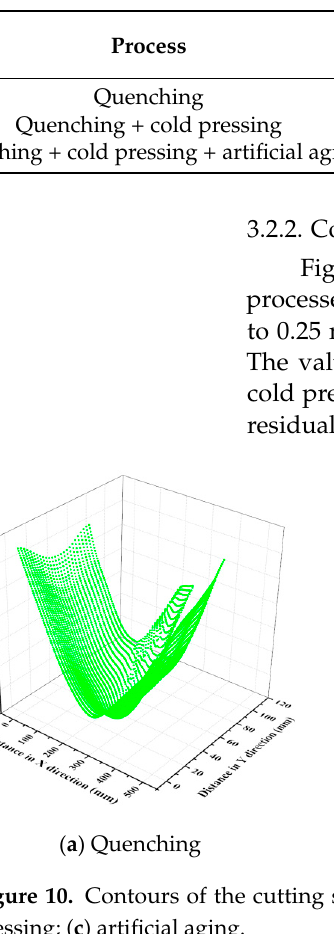
Table 3. Average surface residual stress after different processes.